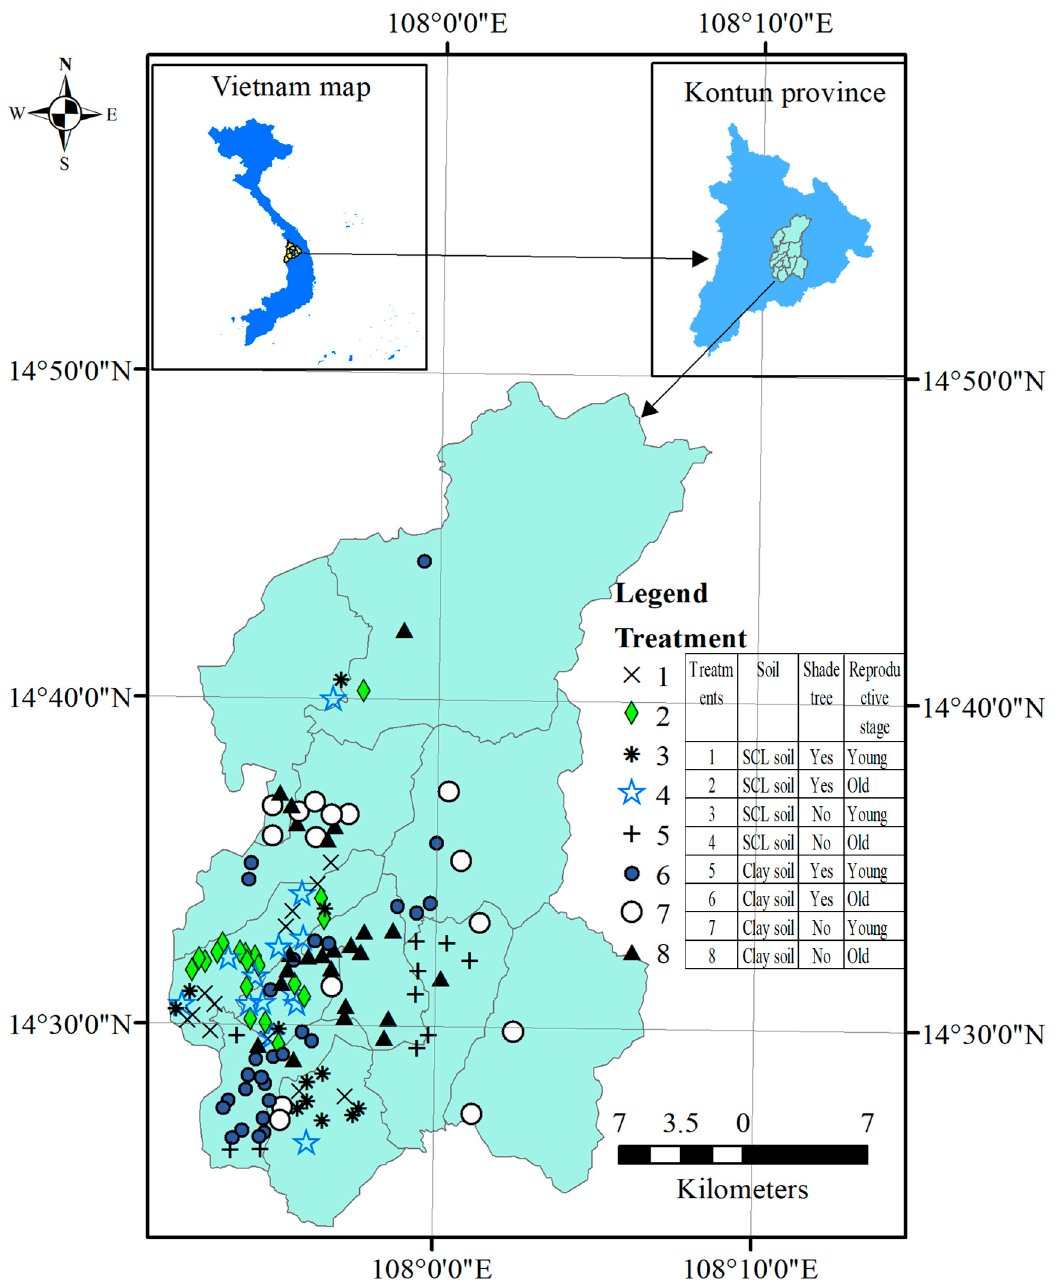
Figure 1. Map of the study area and sampling sites in Dakha, Kontum, Vietnam. SCL = sandy clay loam. The map was drawn using ArcGIS 10.7 (Esri, CA, USA).